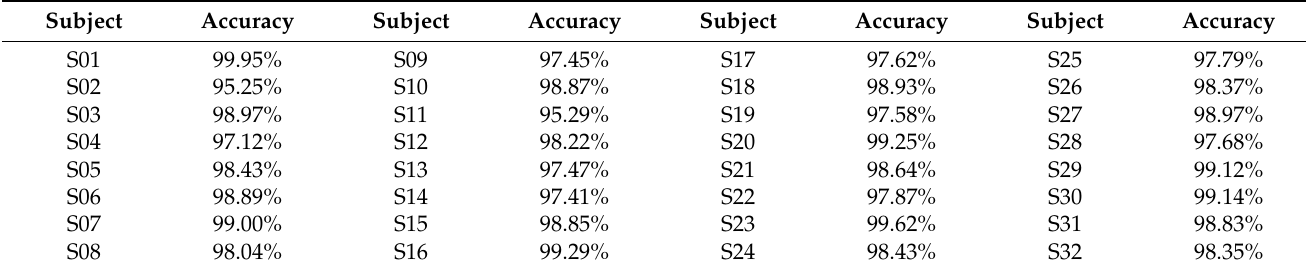
Table 5. Recognition Accuracy for each subject on “Valence”.